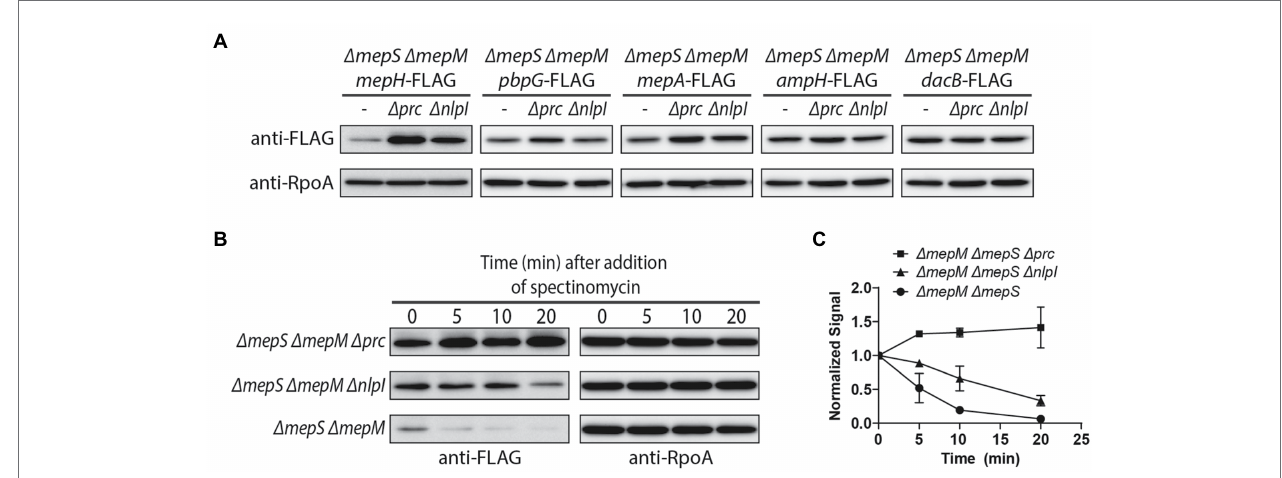
FIGURE 6 | Prc and NlpI are involved in the negative regulation of MepH levels. (A) Comparison of DD-endopeptidase levels in the Δ mepS Δ mepM , Δ